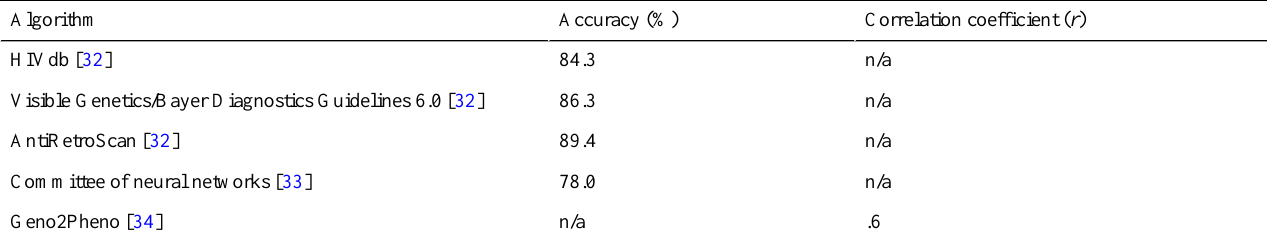
Table 5. Accuracy of predicting ARV drug resistance (%) or correlation coefficient ( r ) reported for various other algorithms and machine-learning techniques.